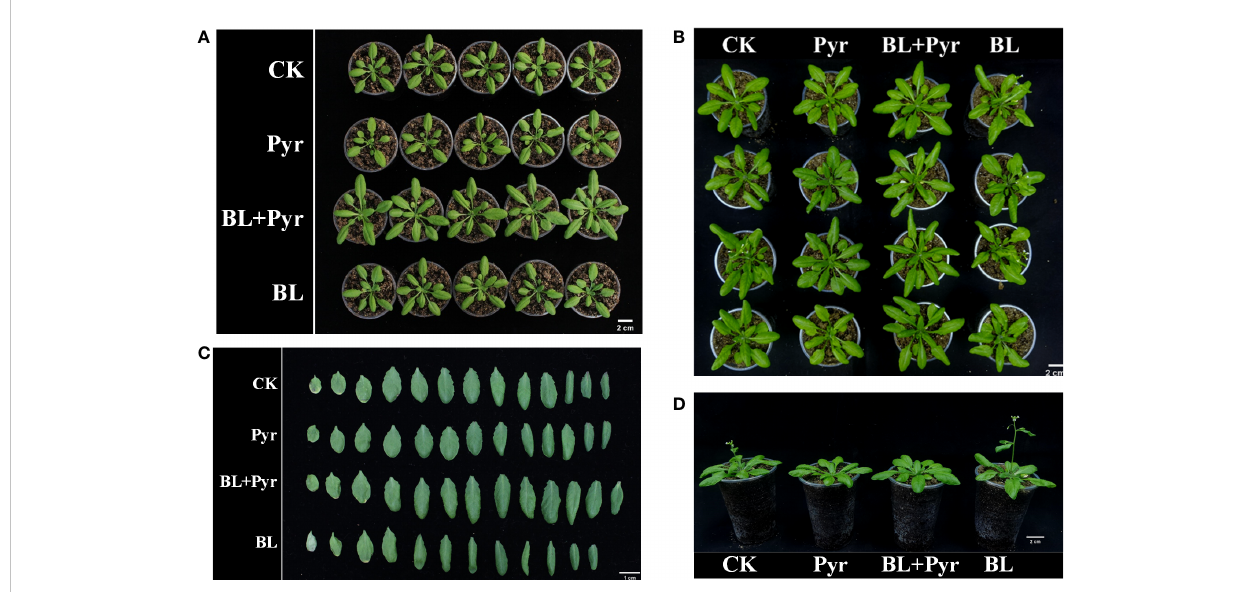
FIGURE 1 BL+Pyr increased the major axis and the fresh weight of rosette leaves during the vegetative growth period. Photos were taken on the 7 th day after the fi rst-round application ( A , 27-day-old seedlings) and 11 th day after the fi rst-round application ( B – D , 31-day-old seedlings). CK, untreated